Question: Compose a caption that would accompany this figure in a paper.
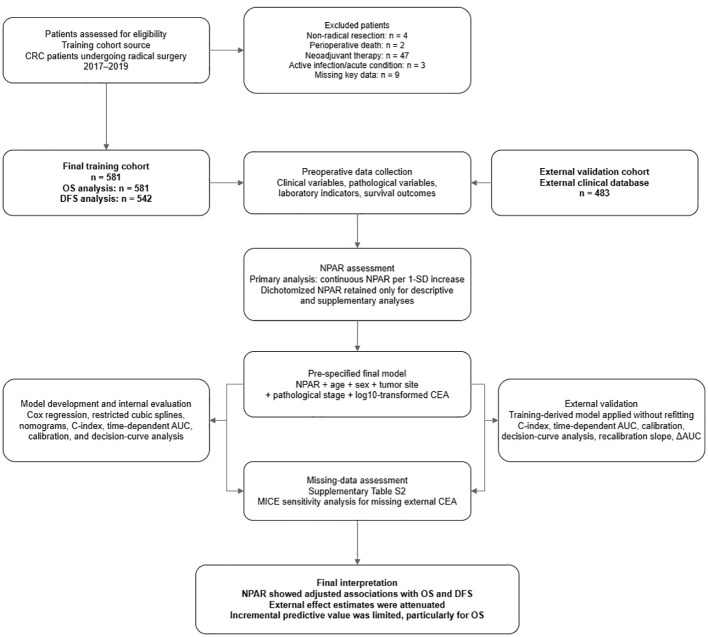
Answer: Integrated study workflow for cohort screening, preoperative NPAR assessment, prognostic model development, internal performance evaluation, missing-data assessment, and external validation.